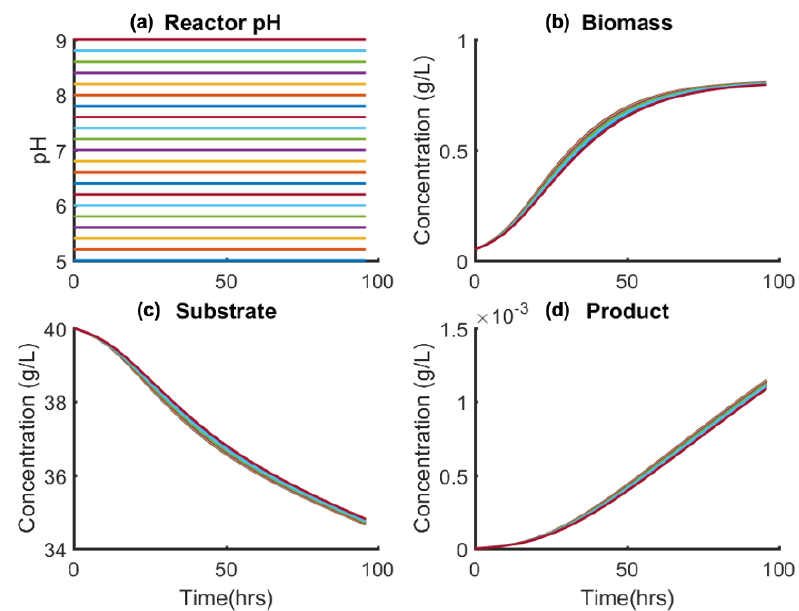
Figure 7. Effect of varying pH ( t ) = constant ( a ) on ( b ) biomass, ( c ) substrate, and ( d ) product concentrations.